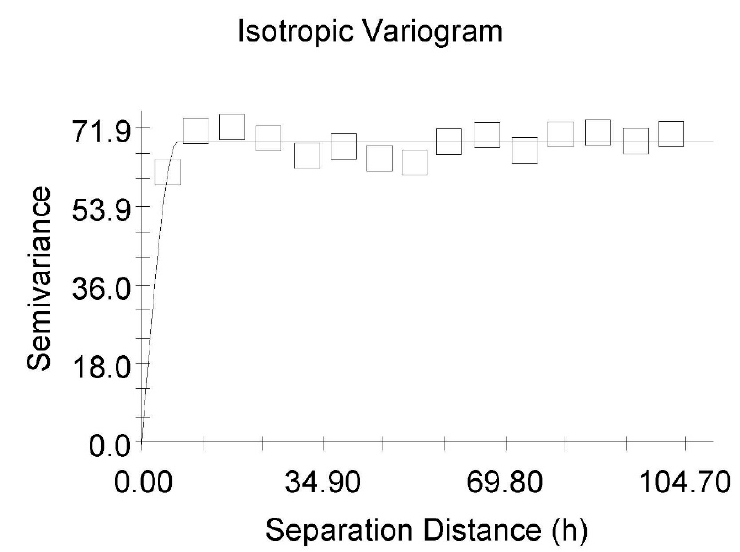
Figure 4. Semivariogram of VMC in the milky dough stage with a spherical model.